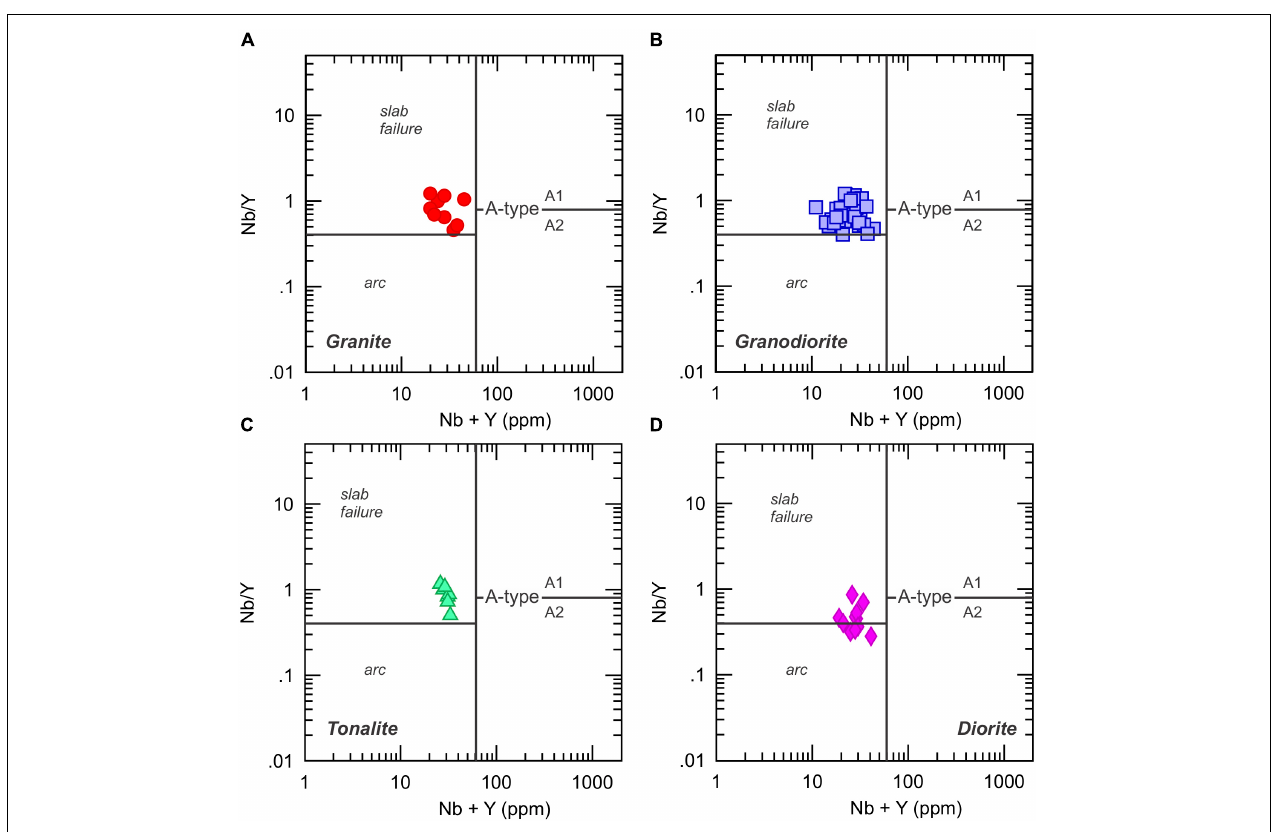
FIGURE 11 | Nb + Y (ppm) vs. Nb/Y discrimination plots used to separate arc, slab failure, and A-type (A1, A2) compositions of the Cretaceous (A) granites, (B) granodiorites, (C) tonalites, and (D) diorites from Kyushu (Whalen and Hildebrand, 2019). Symbols as in Figure 2 .